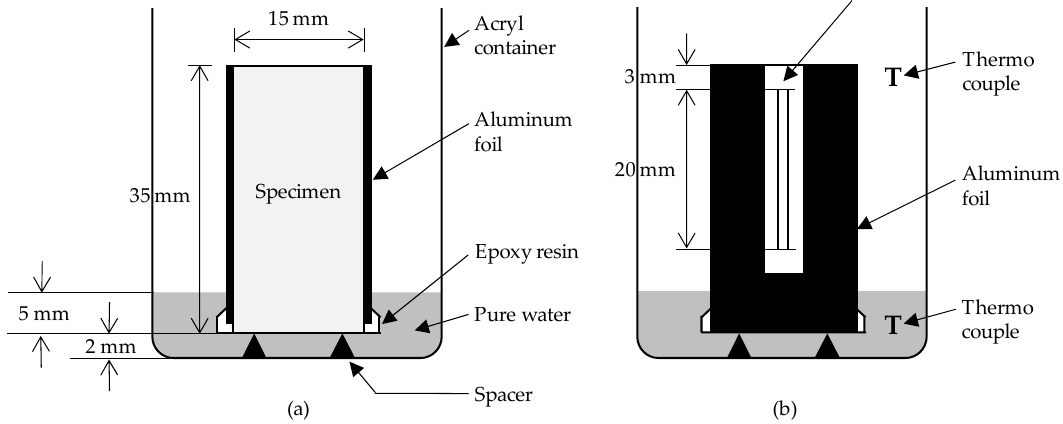
Figure 2. ( a ) Capillary suction test setup for mortar (section). ( b ) Strain measurement test setup for mortar during freeze–thaw cycles (elevation).